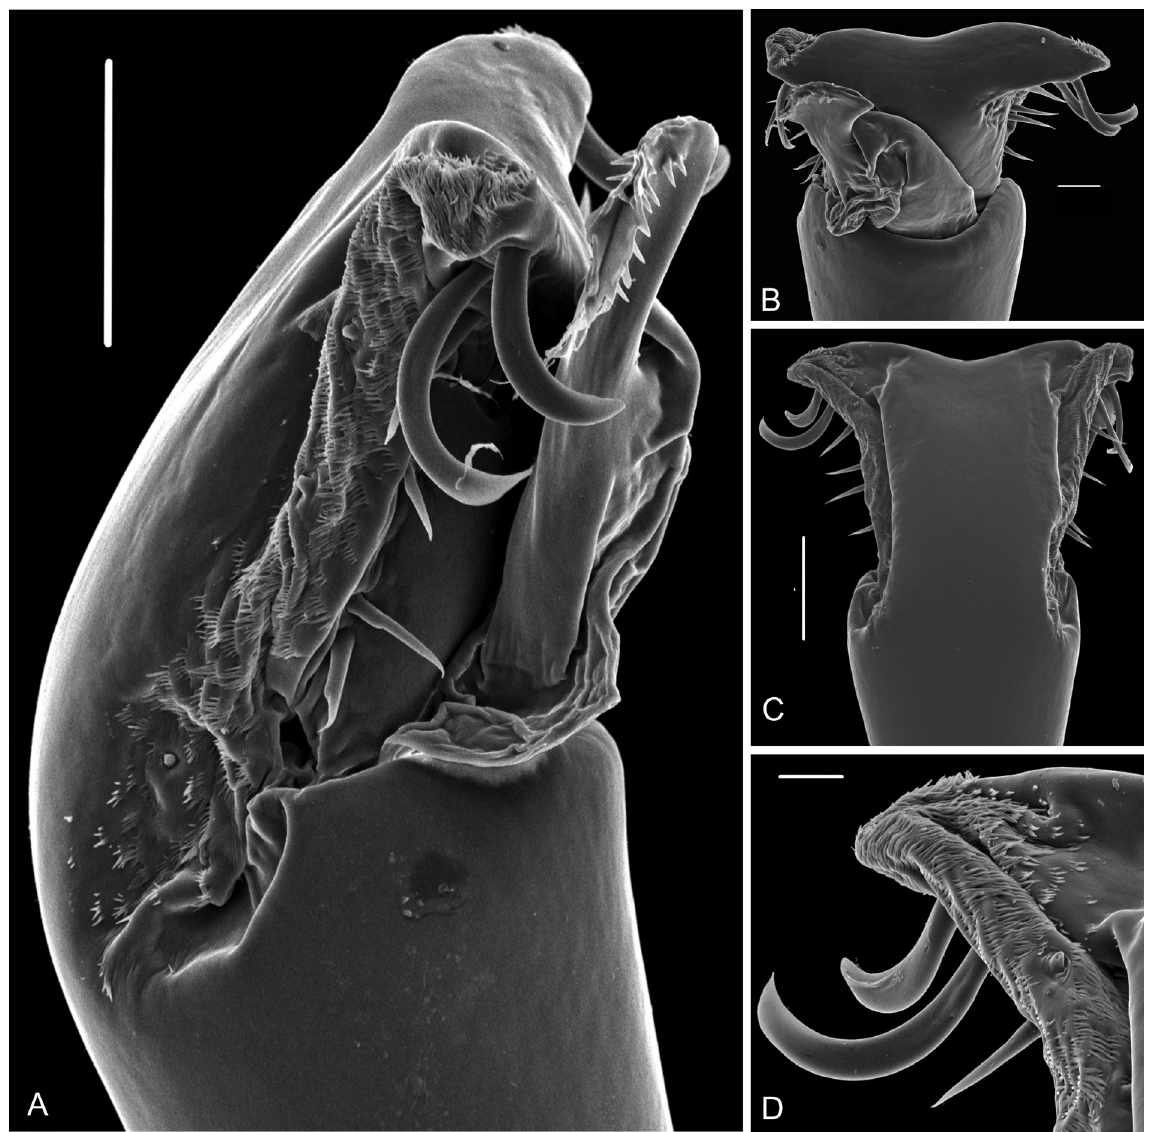
Fig. 30. Eulibitia scalaris (Sørensen in Henriksen, 1932) comb. nov., ♂ (ICN-AO 1208), distal part of penis. A . Lateral view. B . Dorsal view. C . Ventral view. D . Detail of MS C, MS D1, MS E1 and microsetae, ventral view. Scale bars: A, C = 50 µm; B = 20 µm; D = 10